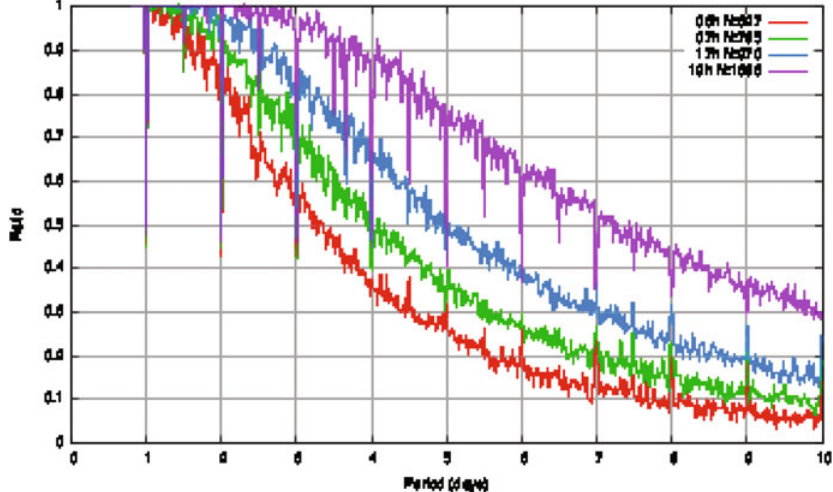
Figure 2. The effect of the observing data pattern and number of epochs on the sensitivity of WTS. A fraction of simulated transiting systems is shown here where there are at least 10 observed in-transit